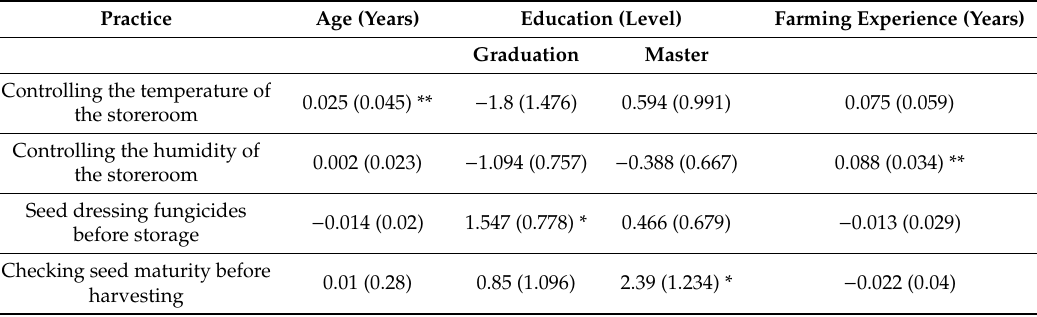
Table 4. Factors influencing farmers practices of seed storage (N = 156).